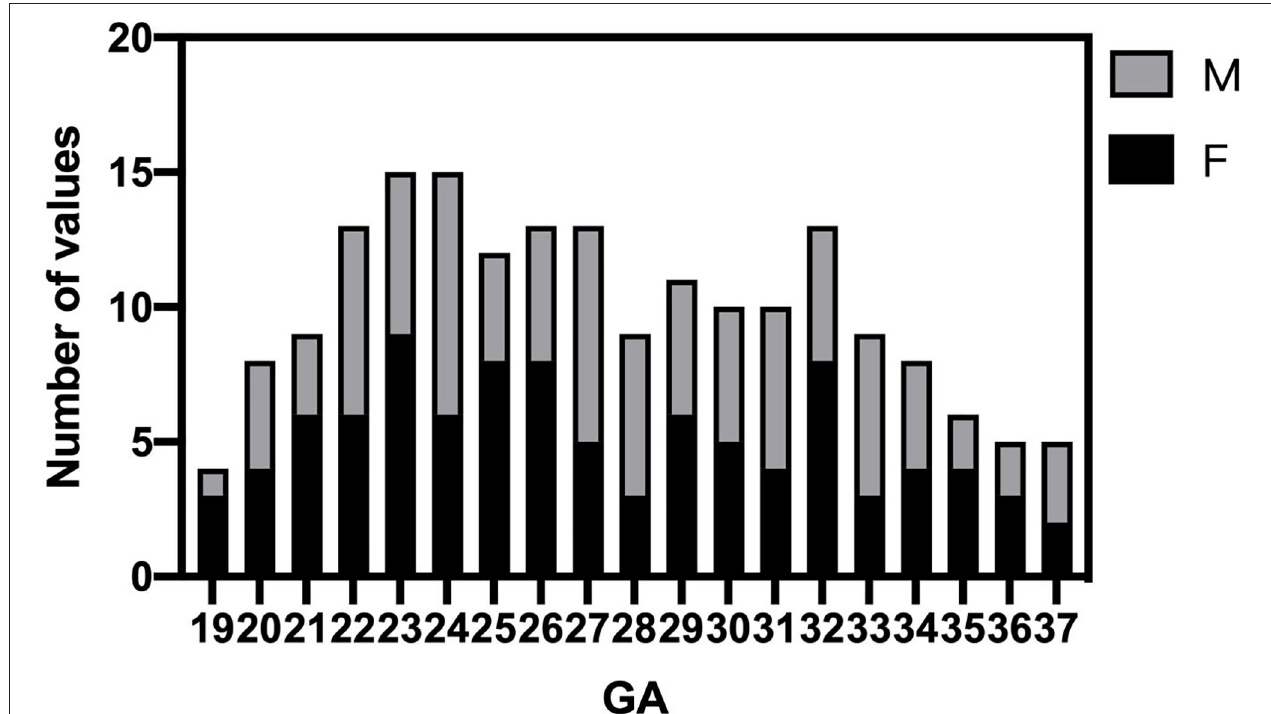
FIGURE 2 | Histogram of gestational age (GA) and sex distribution of MR scans in normal fetuses ( n = 188).